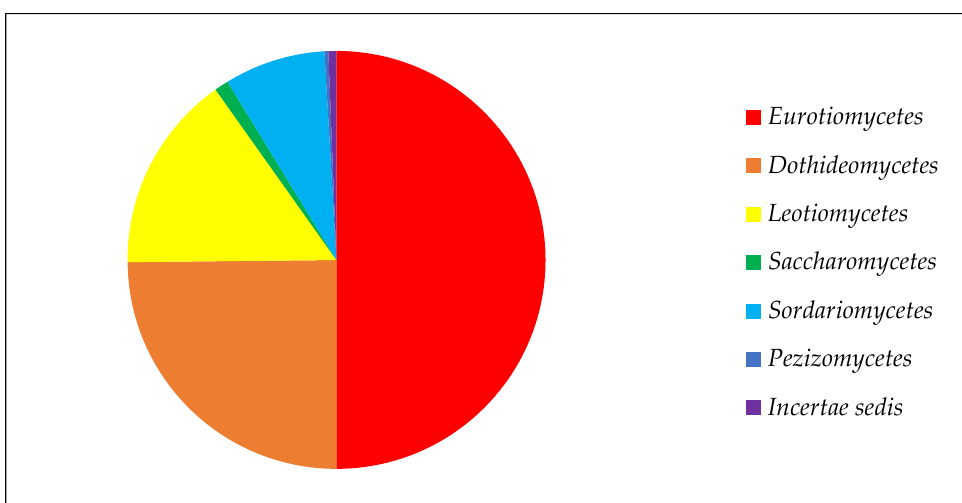
Figure 1. Composition of ascomycetous fungi in collection of paleofungi.